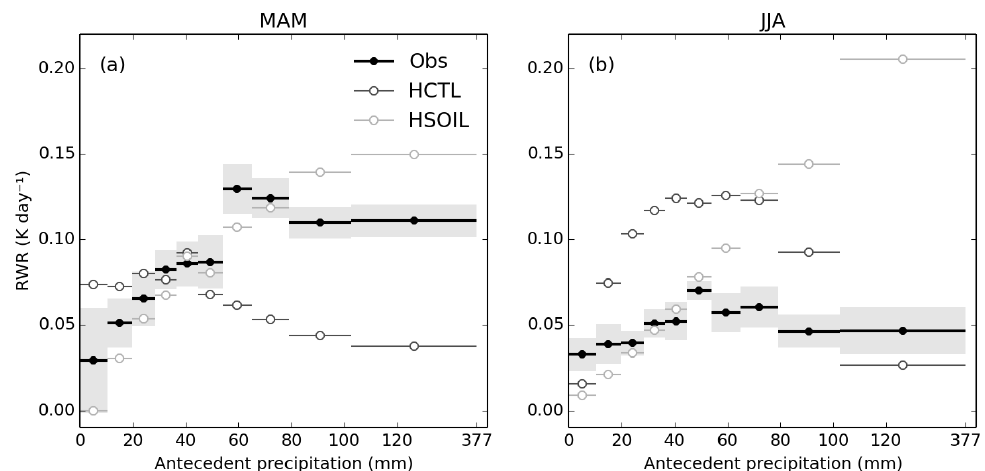
Figure 21. Example of usage of land surface temperature during dry episodes after a precipitation event. The plot shows a composite of the so-called Relative Warming Rate (RWR) as a function of the amount of precipitation during the preceding event for March–April–May (MAM, left ) and June–July–August (JJA, right ). RWR quantifies the increase in dry spell land surface temperature relative to air temperature, and is a measure for the evaporation regime of the land surface.